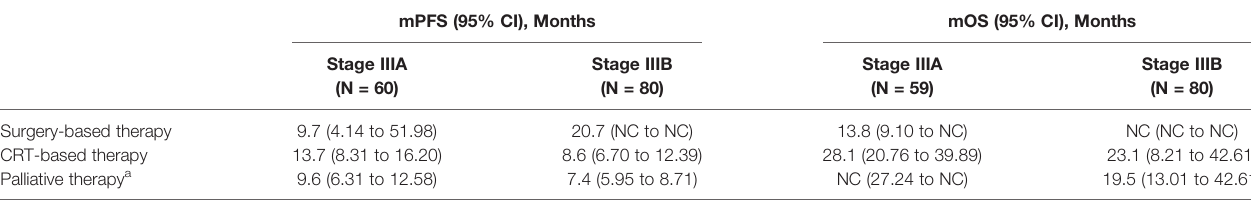
TABLE 3 | Survival outcomes in stage III NSCLC in Vietnam as per Initial treatment regimen and stage (7 th Edition AJCC).